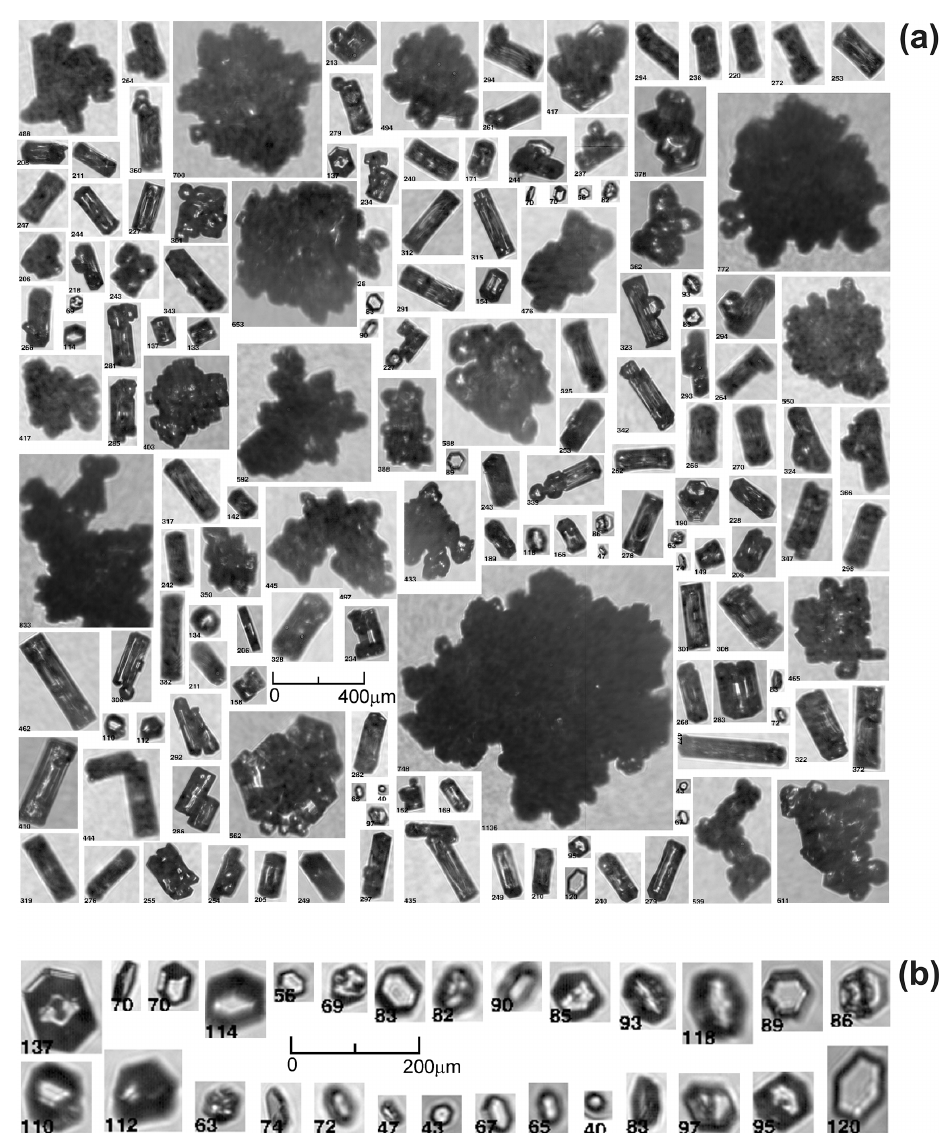
Figure 10. (a) Spatial sequence of CPI images; (b) subset of droplets and faceted ice crystals from panel (a) . Numbers under each image indicate their maximum sizes ( L max ). No liquid droplets were present in this cloud region. The images were sampled T a = − 14 ◦ C and H = 7200m during 12:05:47–12:05:53UTC on 15 May 2015 during measurements shown in Fig. 8.